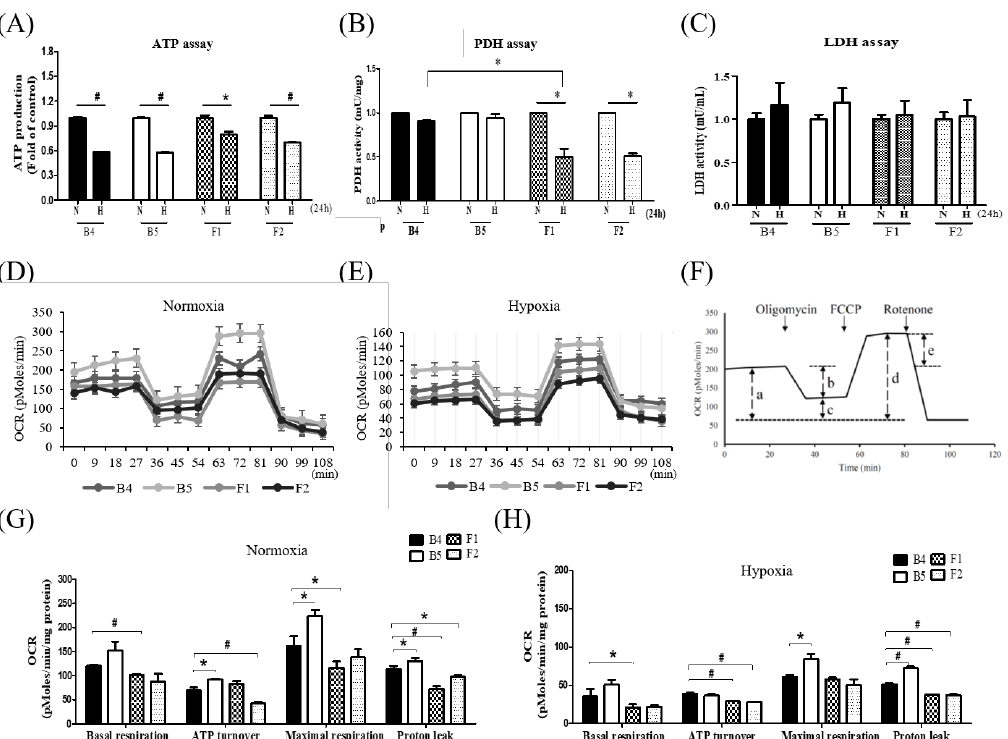
Figure 2. Metabolic profile of di ff erent cybrids after hypoxia-ischemia. Comparison of ATP production ( A ), pyruvate dehydrogenase (PDH) activity ( B ), lactate dehydrogenase (LDH) activity ( C ) under hypoxic-ischemic condition in cybrid cells harboring stroke-susceptible haplogroup F and stroke-resistant haplogroup B. Measurements of oxygen consumption rate (OCR) under normoxic ( D ) and hypoxic ( E ) conditions, and comparison of the fundamental OCR parameters under normoxic ( G ) and hypoxic ( H ) conditions, in cybrid cells harboring stroke-susceptible haplogroup F and stroke-resistant haplogroup B. ( F ) represents the fundamental parameters of mitochondrial OCR including basal respiration (a), coupled respiration (b), uncouple respiration (c), maximal respiration (d), and spare respiratory capacity (e). Mitochondrial ATP levels, PDH and LDH activity were determined by the colorimetric assay kit. Data represent the mean ± SD of at least three independent experiments (* p < 0.05; # p < 0.005). N was used to represent normoxic and H to represent hypoxic condition. OCR examined by the Seahorse XF24 analyzer in the absence or presence of oligomycin (1 µ M), FCCP (250 nM), and rotenone (1 µ M) under normoxic or hypoxic conditions, data obtained by counting 1 × 10 5 cells of